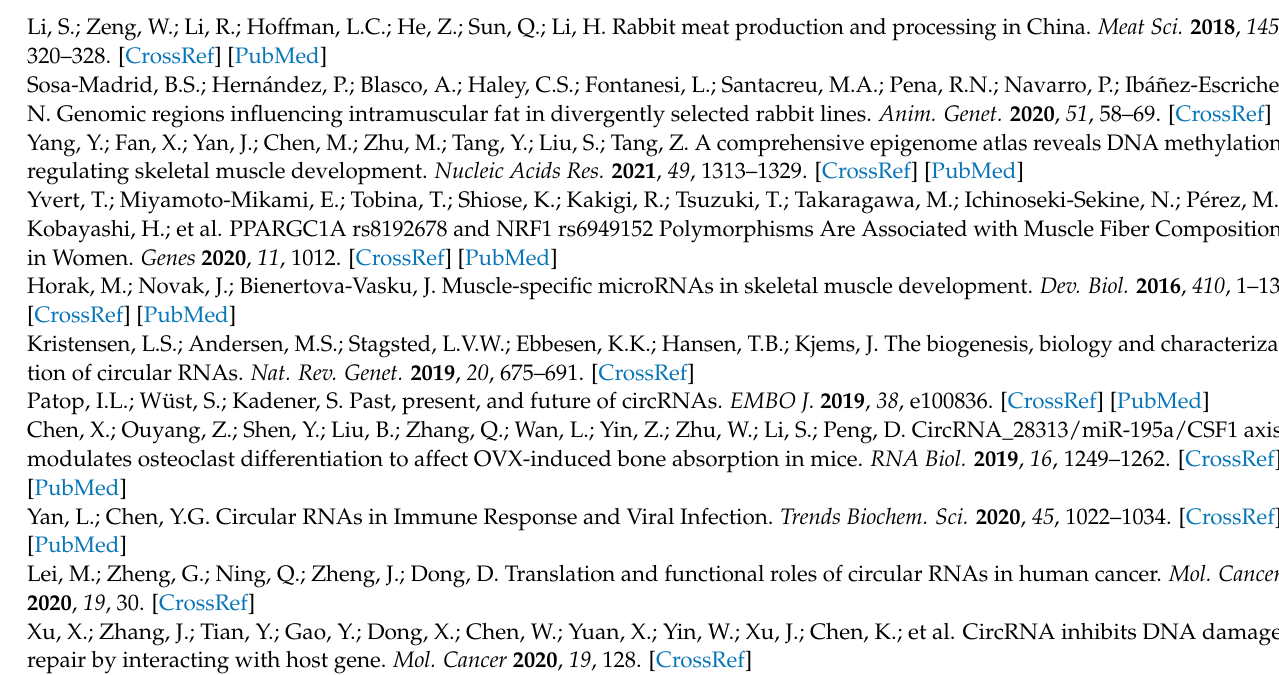
Table S2: Differential analysis of mRNAs in D35 vs. D0; Table S3: Differential analysis of mRNAs in D70 vs. D35; Table S4: The significantly enriched muscle development-related GO-BP terms by the D35- and D70-selective mRNAs; Table S5: Prediction of putative circRNA–miRNA interaction pairs from D0 to D35; Table S6: CircRNA–miRNA–mRNA network from D0 to D35; Table S7: Prediction of putative circRNA–miRNA interaction pairs from D0 to D35; Table S8: CircRNA–miRNA–mRNA network from D35 to